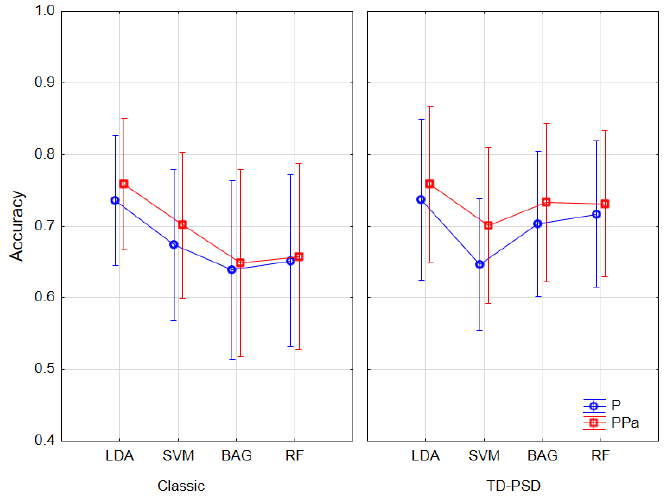
Figure 4. Interaction of Feature Vector, Look-Back Filter Method and Classifier on prediction accuracy.